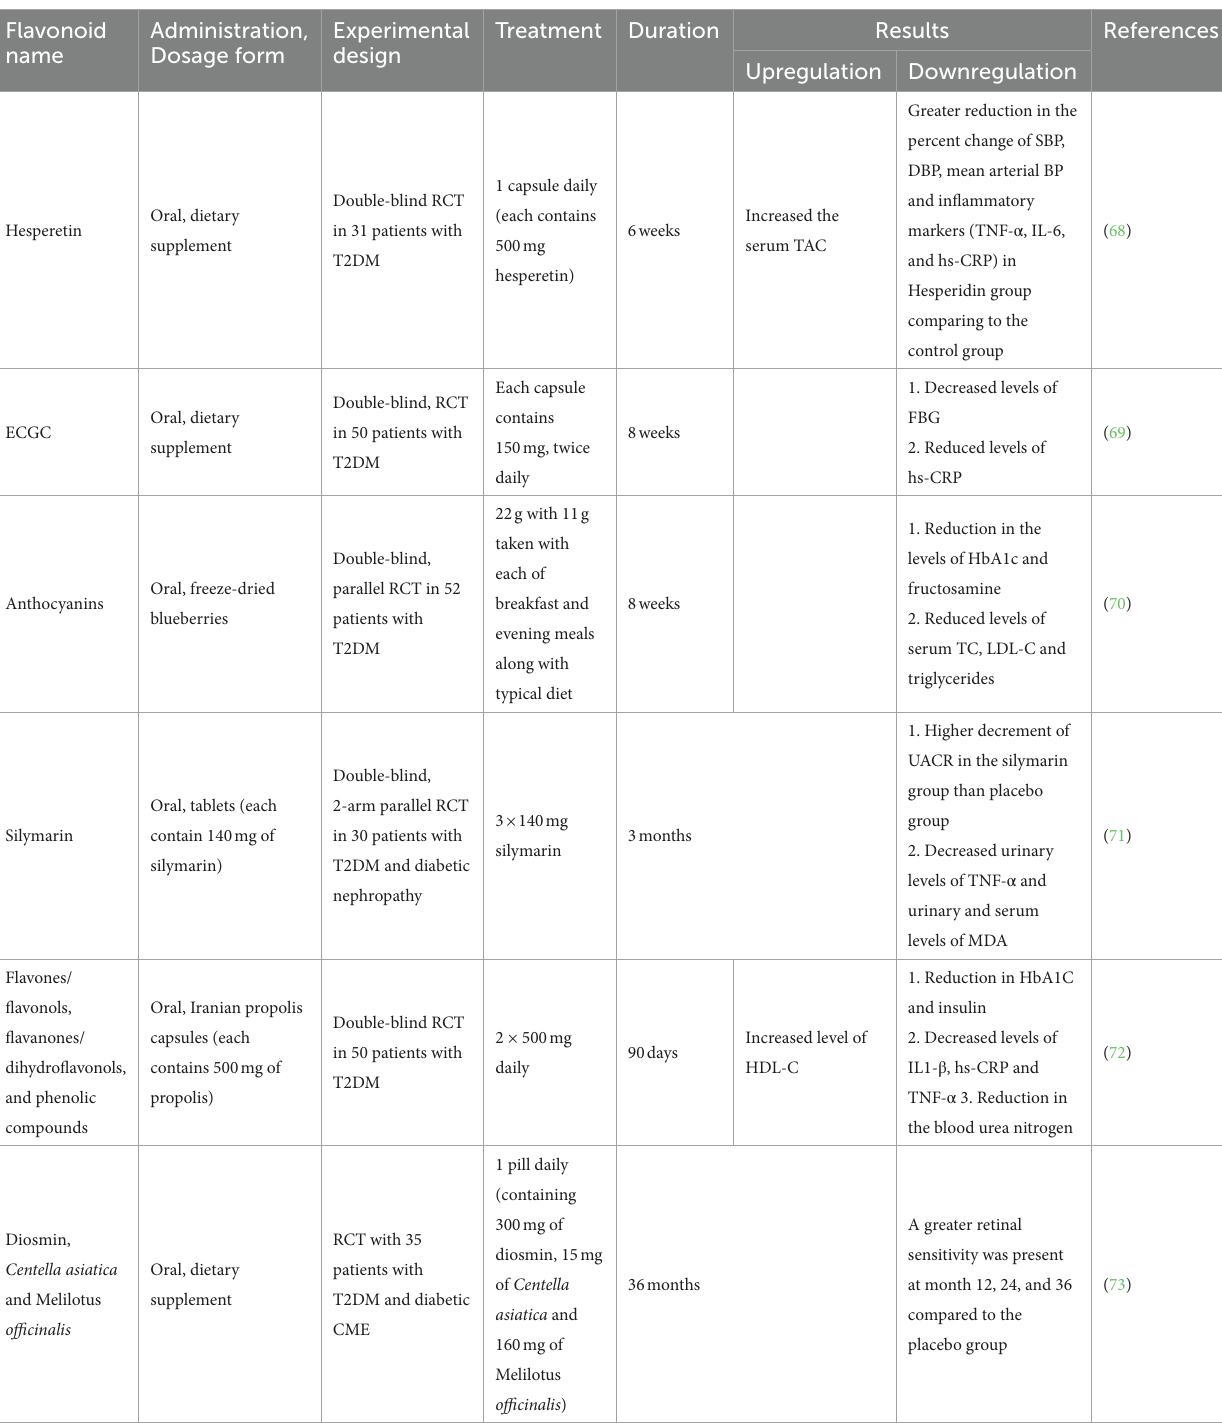
TABLE 3 Protective effects of flavonoids against diabetic complications—clinical